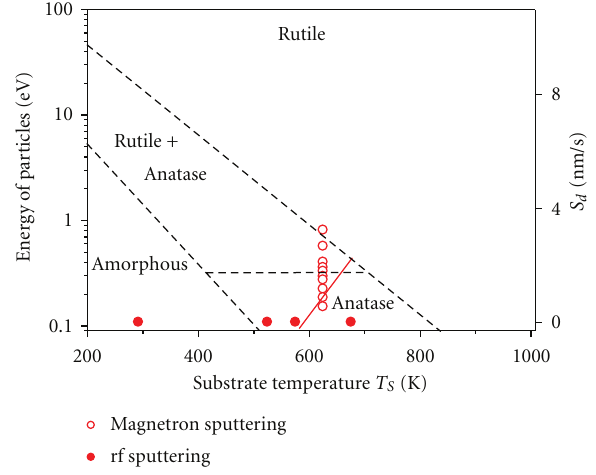
Figure 2: Phase composition diagram after L¨obl et al. [47] modified to include the results obtained for TiO 2 thin films discussed in this work; S d : deposition rate of thin